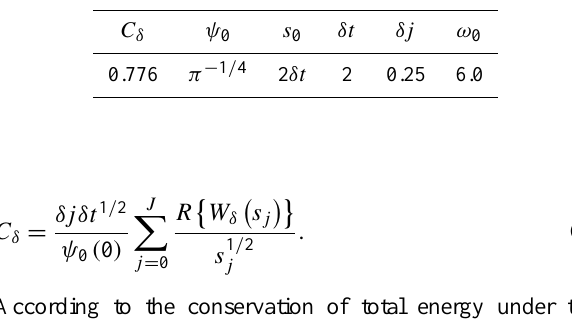
Table 5. Values of the parameters of the Morlet transform in this